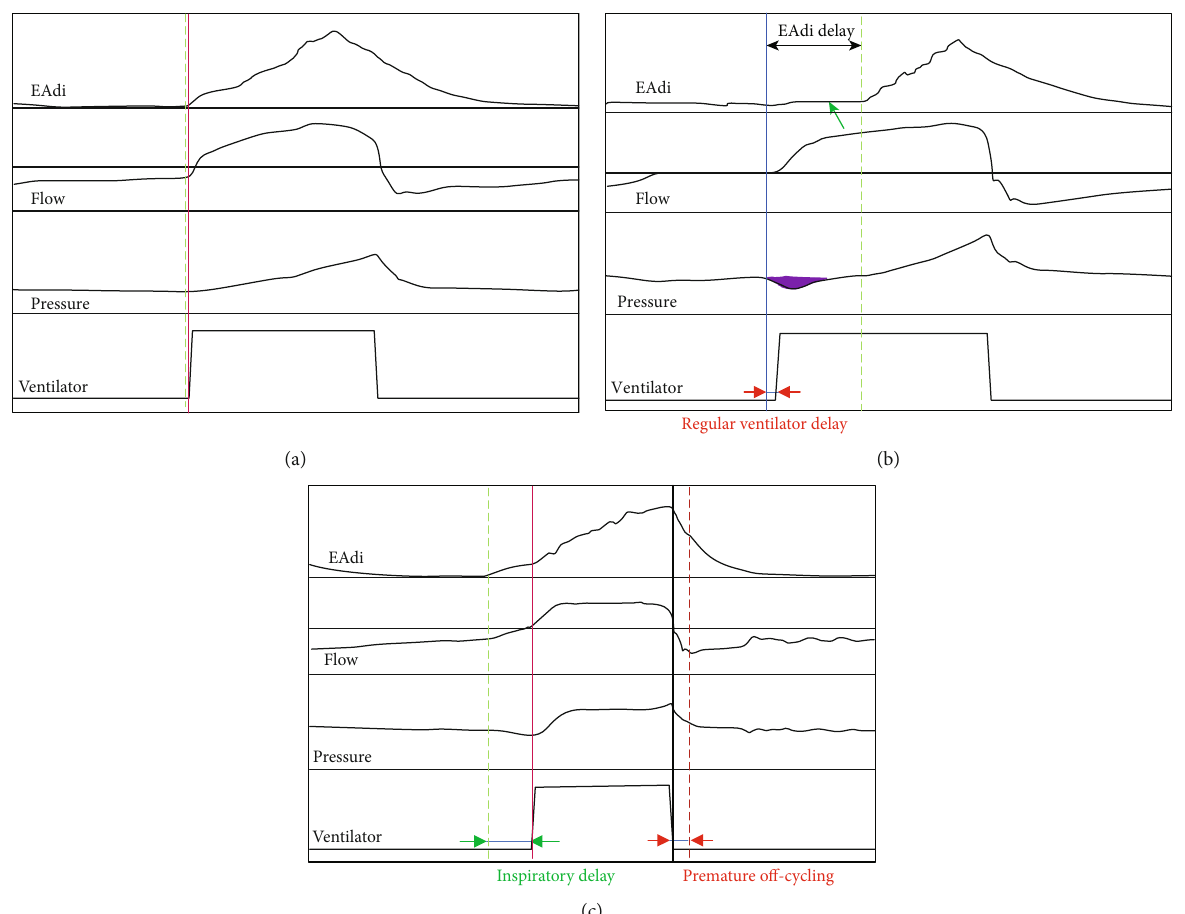
Figure 3: Presented are three di ff erent screenshots of ventilator tracings; tracing on top always EAdi, second tracing fl ow, third tracing pressure, fourth tracing ventilator signal. The axes are as follows: EAdi in microvolt, fl ow in liters per minute, pressure in mbar, ventilator dichotomous o ff /on, y -axes: time in milliseconds. Values are spared intentionally because this fi gure should be seen as a schematic rather than a visual representation of study data. (a) Perfect neuronal triggering, the ventilator cycles on (red vertical line) at exactly the same time as the increase in EAdi signal tracing (green broken vertical line) happens; times not marked because in this perfectly triggered breath there is no delay. (b) Visual presentation of the concept of “ EAdi true ” . The time point marked with the black double-arrow is the moment when a decrease in pressure happens but the EAdi tracing does not show an increase, rather does it show the plateau mentioned in the text, representing a blacked out ECG signal (green arrow). During the plateau inspiratory activity of the diaphragm cannot be detected. The start of inspiration is therefore not where the EAdi tracing starts to rise, but rather where a drop in pressure tracing during the EAdi-plateau is detected. This is where the EAdi-signal would rise, if ECG “ disturbance ” had not happened. EAdi-delay: black double- arrow; regular ventilator delay: red arrows; purple area: negative pressure swing. (c) Pneumatically triggered breath during PSV, visual presentation of inspiratory and expiratory delay. The beginning of the EAdi tracing representing the start of inspiration is marked by the vertical broken green line. The start of ventilator activity (red vertical line) happens belated relative to EAdi but perfectly in time in regard to PSV criteria. Without the EAdi tracing this inspiratory delay cannot be detected. The end of ventilator activity (black vertical line) happens before EAdi tracing has reached the o ff -cycling criterion (vertical broken red line, 70% EAdi-peak); at this moment, the patient ’ s diaphragm was still activated denoting that inspiration was still ongoing. Expiratory delay is marked by red